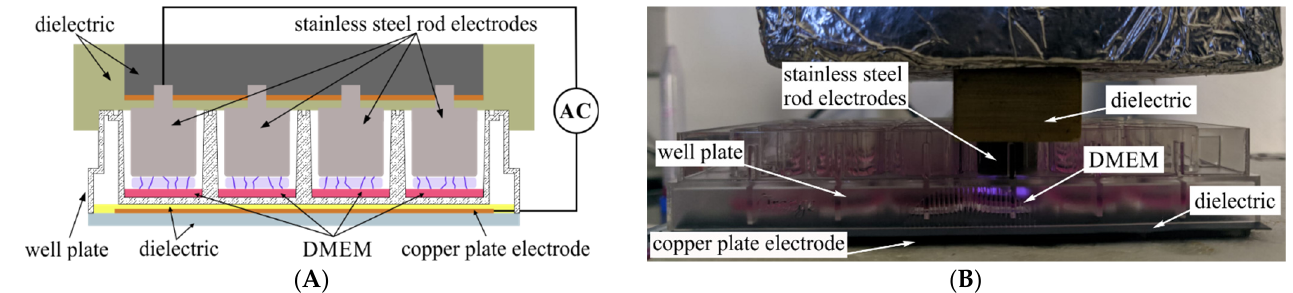
Figure 1. The schema ( A ) and working setup ( B ) for air DBD plasma experimental exposure system for DMEM activation.